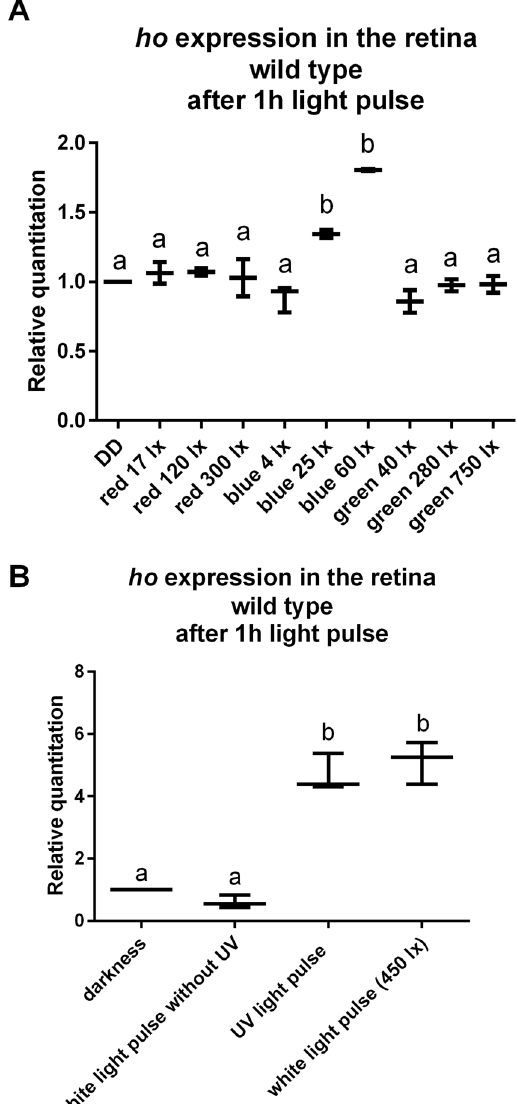
Figure 3. The ho gene mRNA level in the retina of Canton S flies after 1 h exposure to light with different wavelengths. ( A ) The following intensities were used for red light: 17, 120 and 300 lx, blue light: 4, 25 and 60 lx, green light: 40, 280 and 750 lx. ( B ) UV light and white light with filtered out UV exposures. Data are normalized to DD (value = 1.0). Statistically significant differences are marked as different letters above bars. The ends of the vertical bars for each time point represent the range of findings, with the more centrally located horizontal bars the